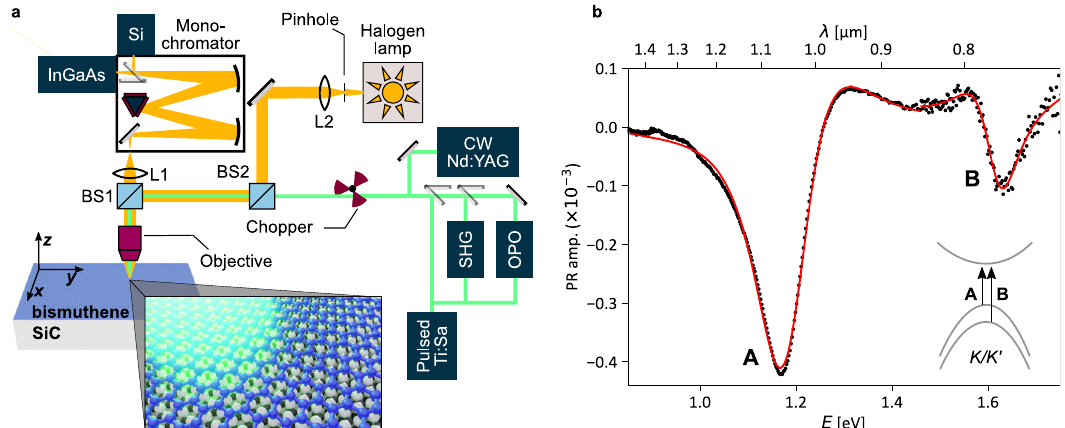
Fig. 2 | Opticalspectroscopy ofBi/SiC. a The experimentalsetup forhigh-spatial- resolution photo-modulated re fl ectivity (PR). b The fundamental excitation spec- trum of bismuthene measured in the PR experiment at T =300K (CW excitation, P A and B are exciton-like PR features centered at E E laser ~2.33eV, ave ~0.5mW).